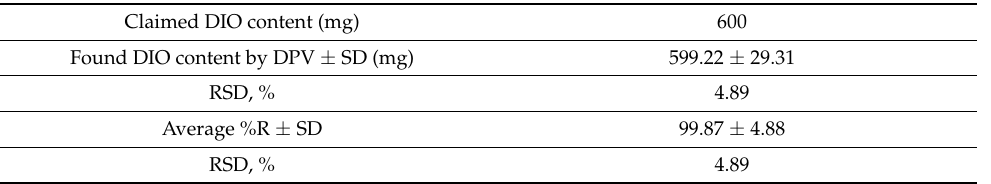
Figure 13. Differential pulse voltammograms recorded on PGE_H for 10 mL sample solution in 0.10 mol/L H 2 SO 4 before and after each addition of 0.30 mL of 5.26 × 10 − 4 mol/L DIO standard. The inset shows the corresponding calibration curve. Table 5. The results obtained by the developed DPV method for quantitative determination of DIO in Revada dietary supplements.